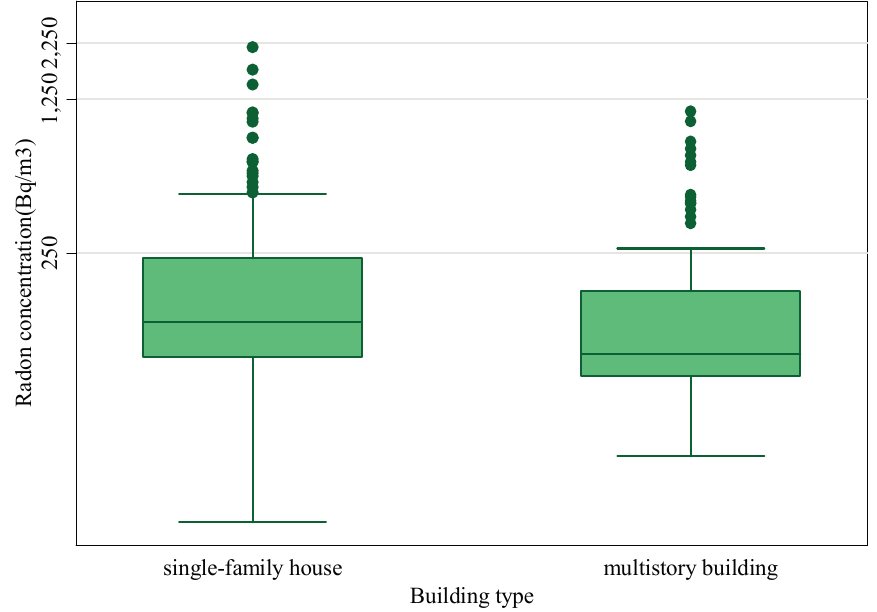
Figure 3. Relationship between radon concentrations and building